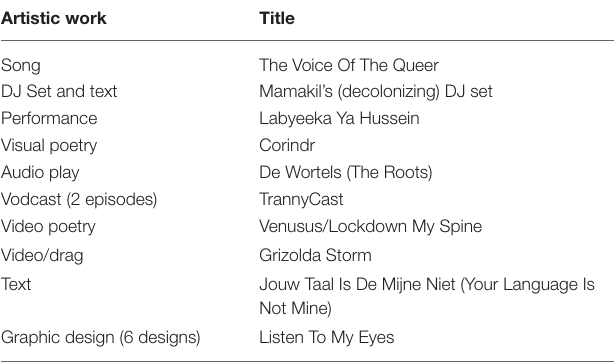
TABLE 1 | Artistic works published in Art for Change 1 . Artistic